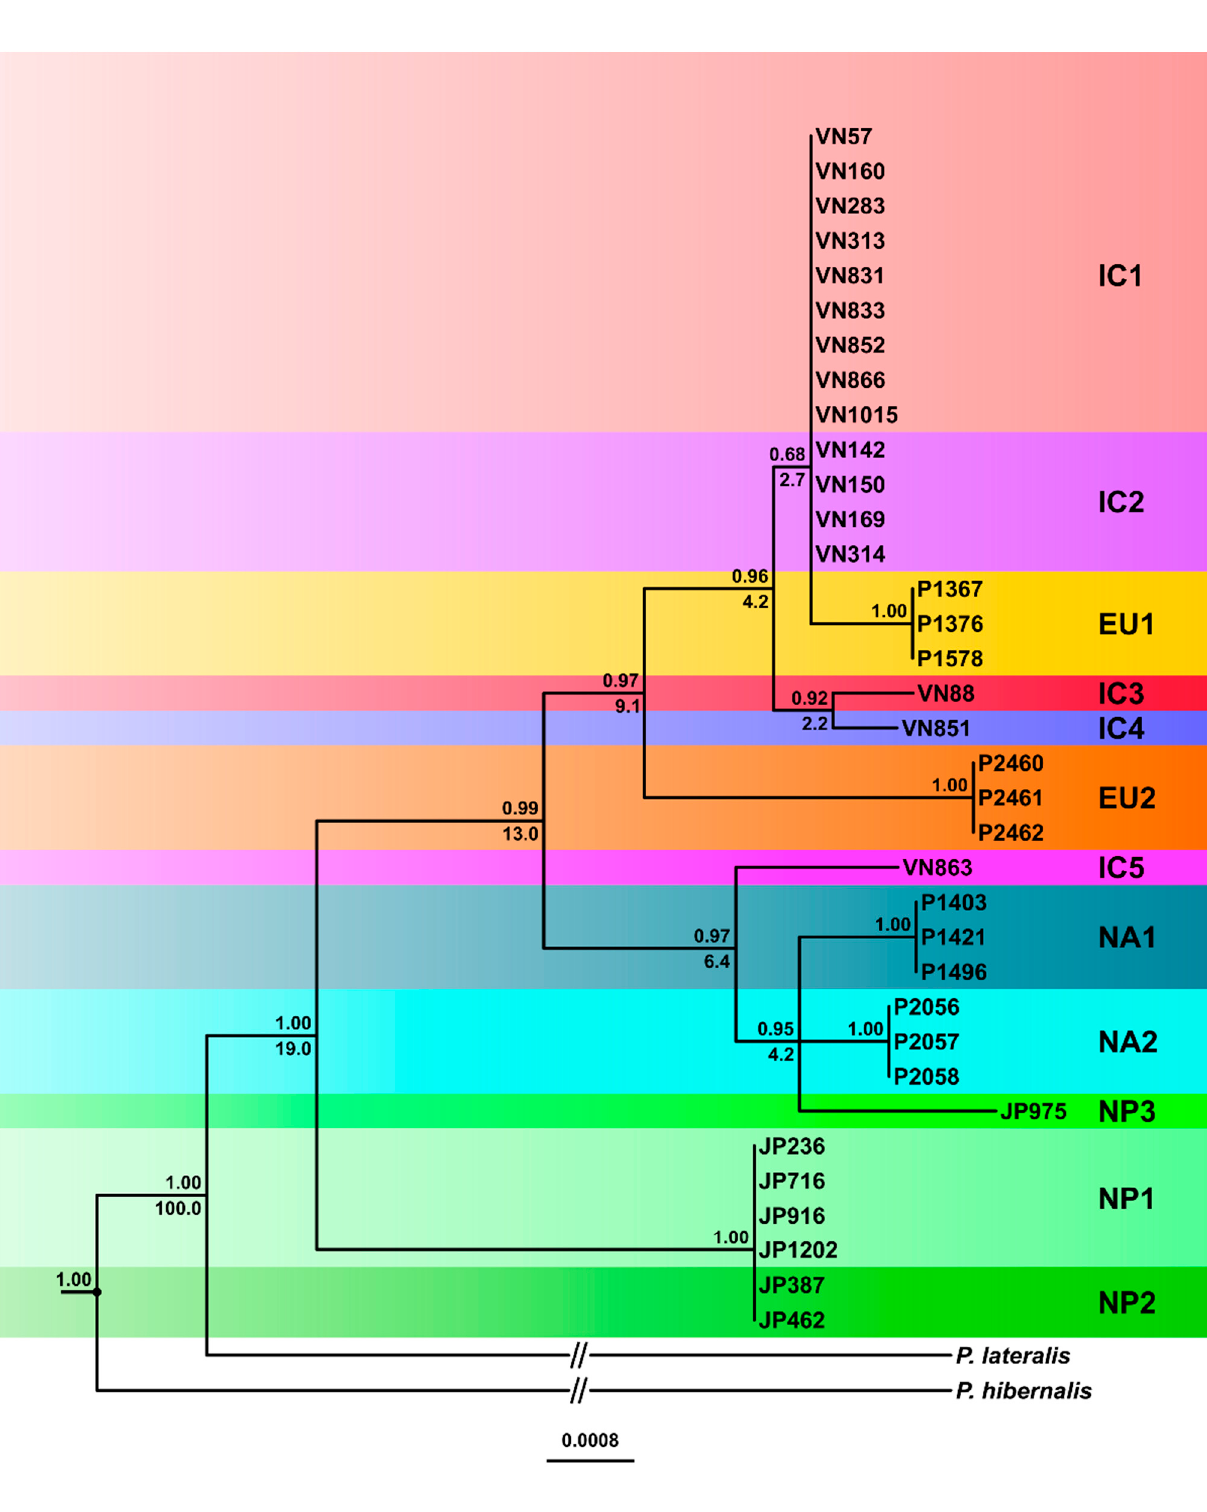
Figure 8. Fifty percent majority rule consensus tree phylogram derived from Bayesian inference analysis of a seven-locus nuclear ( Avh120 , Avh121 , btub , gwEuk.30.30.1, hsp90 , ITS and trp1 ) dataset of the five Indochinese phenotype groups (IC1-5), the three Japanese phenotype groups (NP1-3) and the four known lineages (EU1, EU2, NA1 and NA2) of Phytophthora ramorum . Bayesian posterior probabilities and relative divergence times (in %) are indicated above and below branches, respectively. Phytophthora hibernalis and P. lateralis were used as outgroup taxa. Scale bar = 0.0008 expected changes per site per branch.